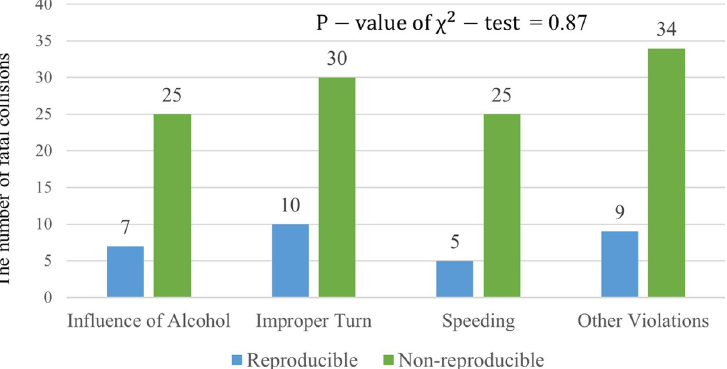
Fig 8. Distributions of primary collision factors for reproducible and non-reproducible fatal collision sites on the six routes from 2006 to 2008.